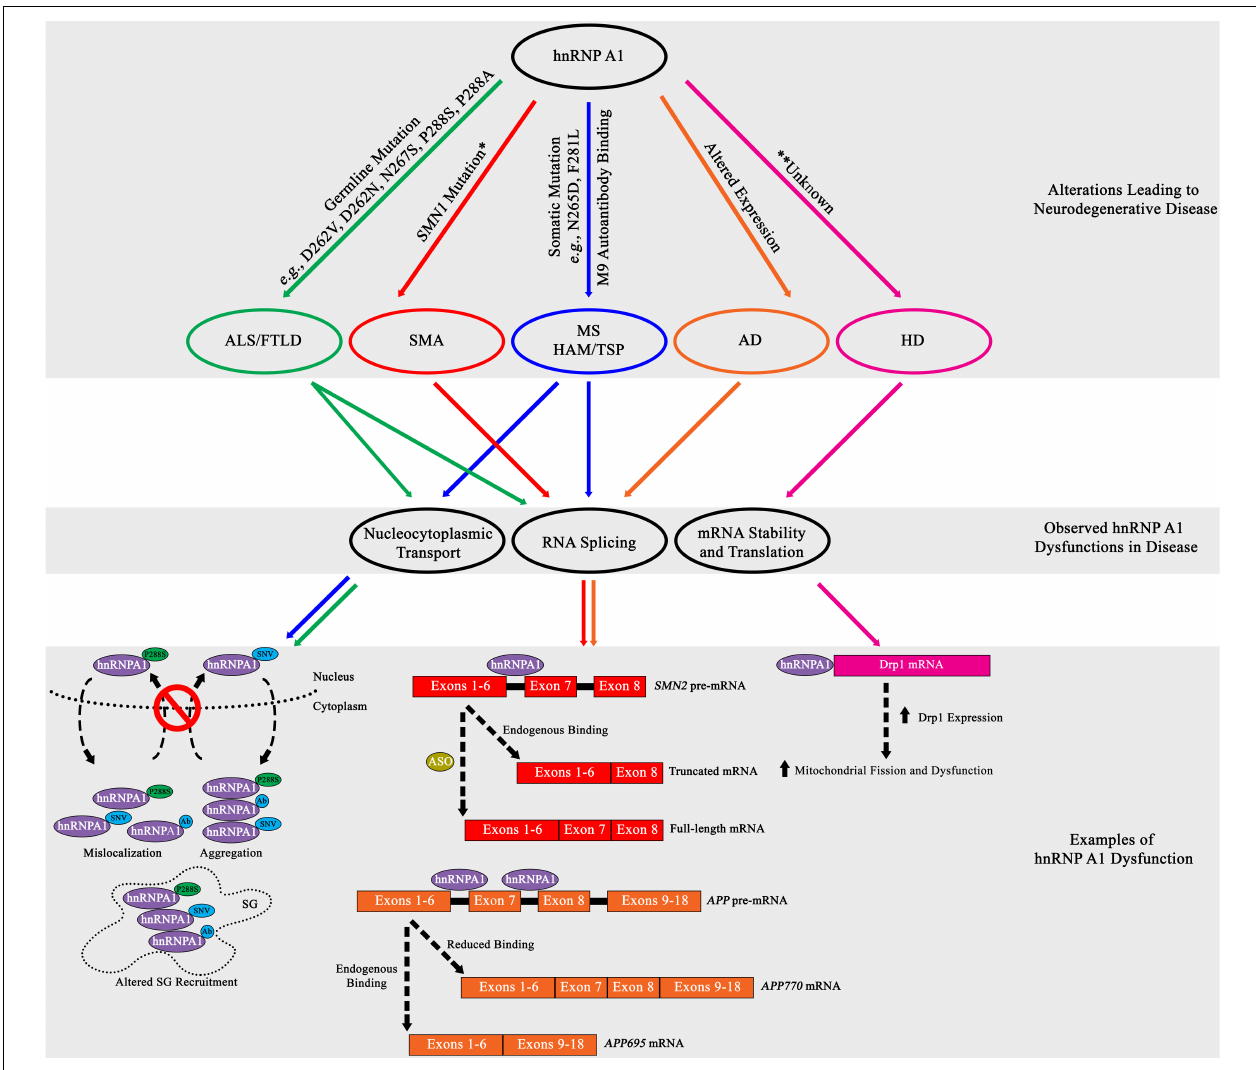
FIGURE 3 | Summary diagram of hnRNP A1 dysfunctional pathways leading to neurodegenerative disease pathogenesis. Top Grey Box: HnRNP A1 alterations that are disease specific (ALS/FTLD, green; SMA, red; MS and HAM/TSP, blue; AD, orange; HD, pink) lead to pathogenesis. Middle Gray Box: Commonly observed hnRNP A1 dysfunctions in neurodegenerative diseases are nucleocytoplasmic transport deficits (leading to protein mislocalization, aggregation and altered SG recruitment), dysregulated RNA splicing, and modification of target mRNA stability. Bottom Gray Box: Selectively highlighted examples of hnRNP A1 dysfunction in neurodegenerative disease. Each dysfunctional mechanism is colour coded for the disease it refers to. Refer to the individual neurodegenerative disease sections for more information. Ab = antibody. *Dysregulation of the SMN1 gene precedes the effects of hnRNP A1